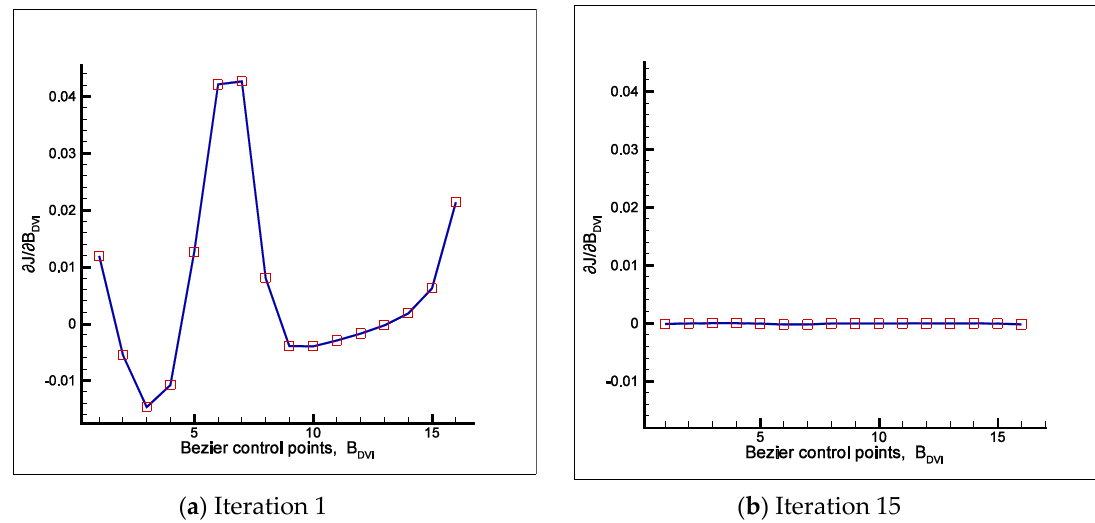
Figure 14. The gradient of the objective function with respect to the design variables at iteration 1 ( a ) and iteration 15 ( b ).